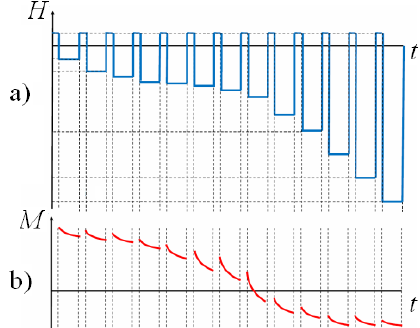
Fig. 2. Scheme of applied magnetic field switching in the